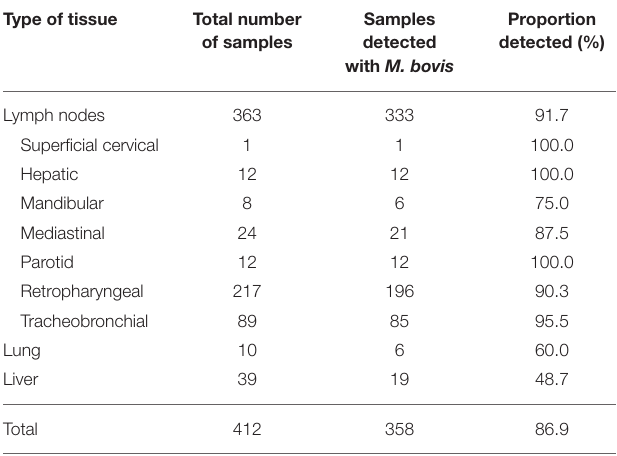
TABLE 1 | Total tissue samples obtained from dairy cattle in Baja California, Mexico for the detection of M. bovis . Type of tissue